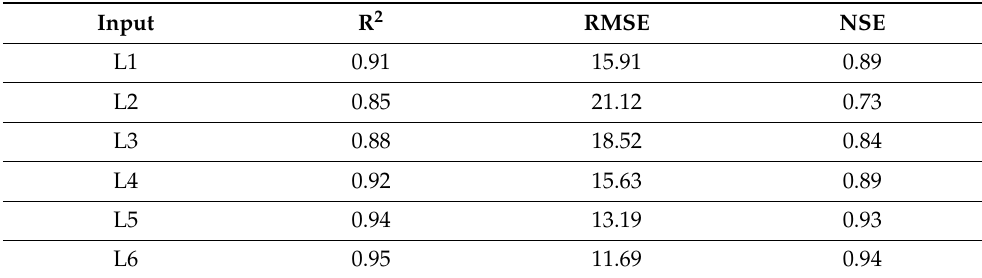
Table 3. Performances of the various input combinations used to estimate runoff.